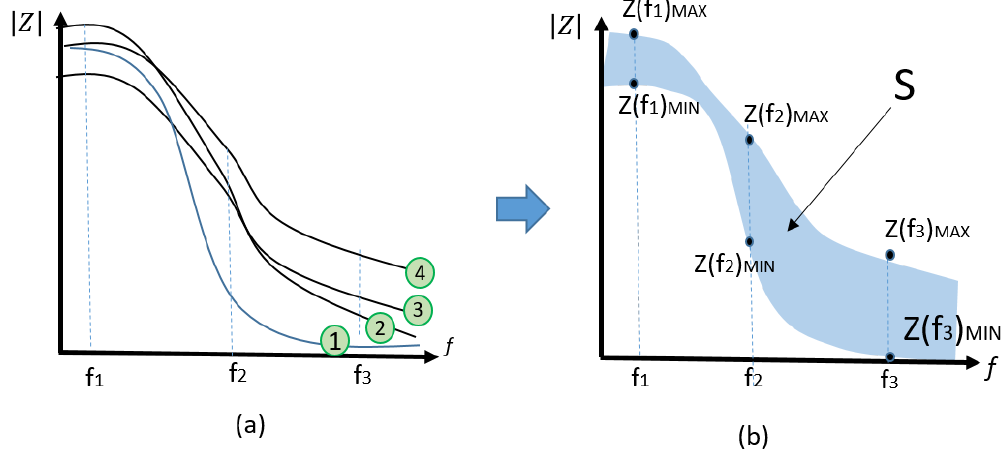
Figure 4. Illustration of ( a ) multi-curves impedance spectroscopy results and ( b ) the covered surface area S.